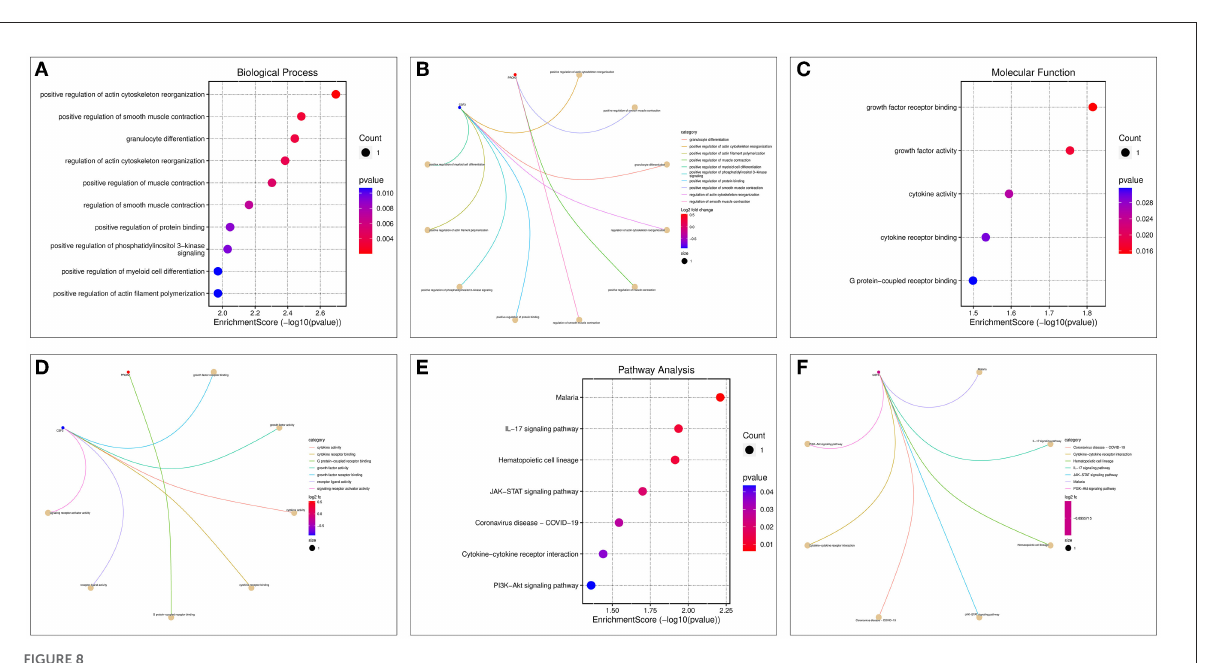
causes neurotoxicity (35). Studies show the involvement of PROK2 in A β -induced toxicity, as A β peptides increase PROK2 expression in AD, representing a new class of pathological markers in AD animal models (40–42). Consistent with the previous studies, our results show